Question: Which visualization type does this figure use?
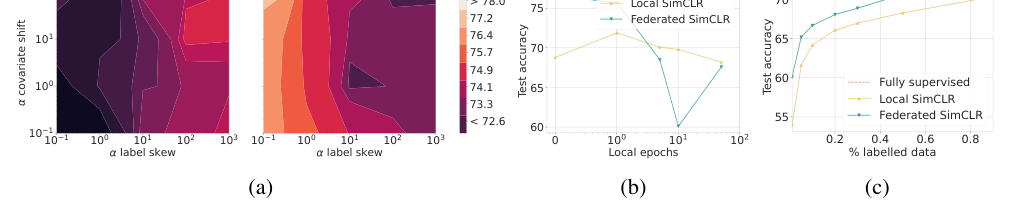
Answer: line